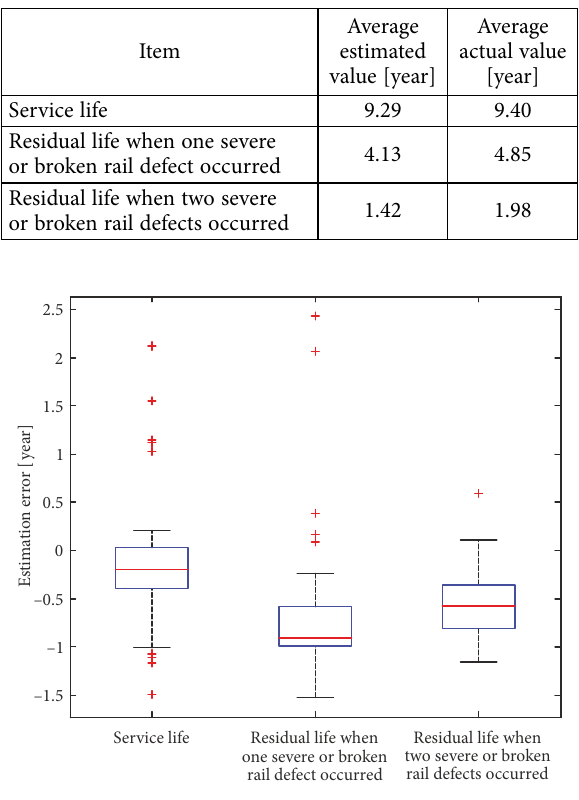
Figure 6. Box plot of estimation errors for service and residual lives Table 6. Distributions of estimation